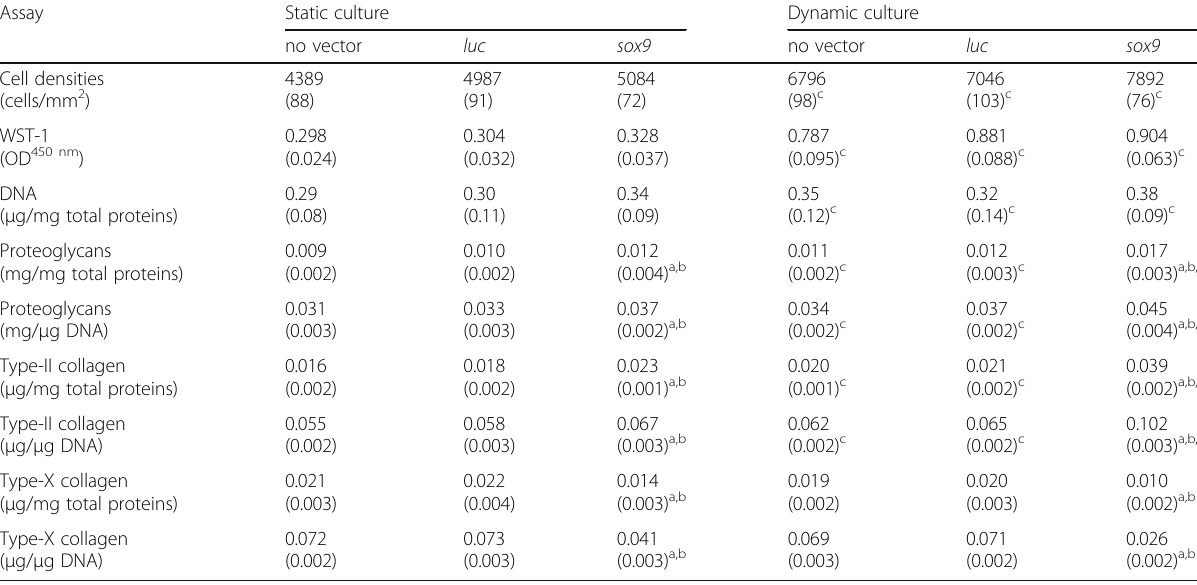
Table 2 Biochemical assays in the rAAV-transduced human bone marrow aspirates (day 28) Assay Static